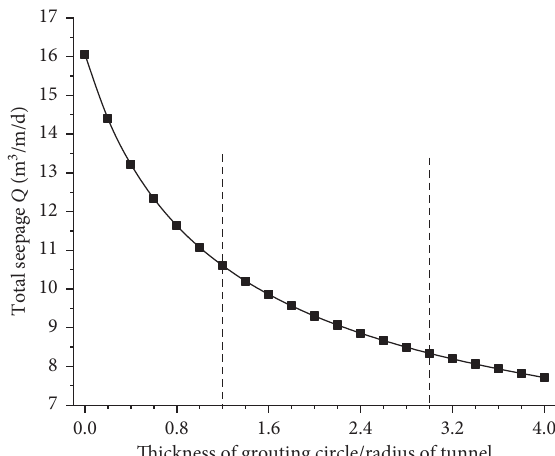
Figure 4: Relationship between the grouting circle thickness and the water seepage.